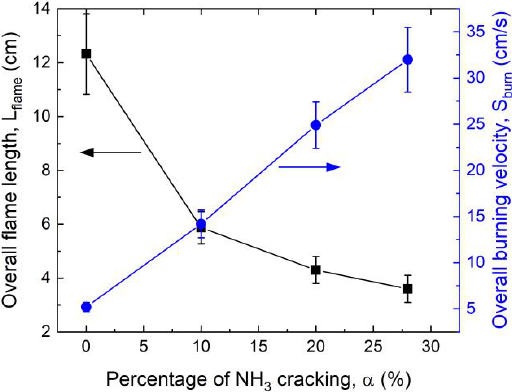
Figure 4. Overall flame length and overall burning velocity of the four NH 3 –H 2 –N 2 –air blends with a global equivalence ratio of Φ = 0.95, a bulk flow velocity of 7 m/s, and a corresponding flame thermal power of about 3.4 kW. Error bars represent uncertainties in the flame dimension measurements.